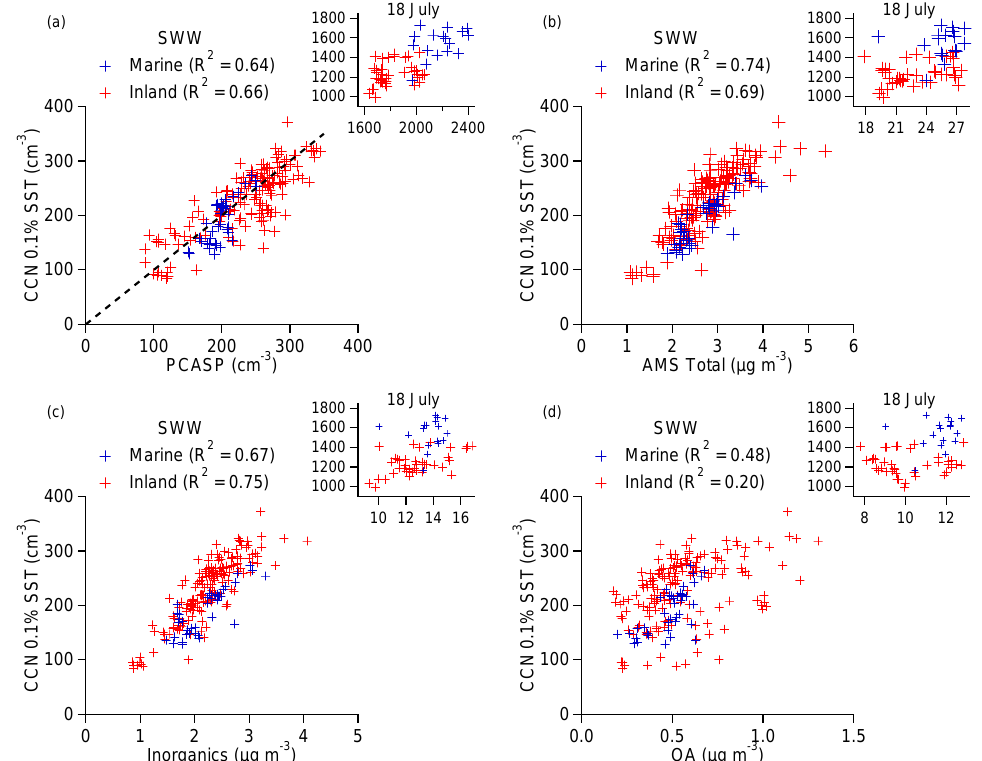
Figure 9. Scatter plots of measured CCN concentration at 0.1%SST with concentrations of aerosol species. The data shown are from 18, 25, and 29 July and 3 August, as CCN data were only available on these days. The blue data points were measured over the NW coast, and the red points were measured inland, as defined in Fig. 2. Data from the SWW and anthropogenic pollution (18 July) cases are separated due to the different meteorological conditions and greatly differing CCN